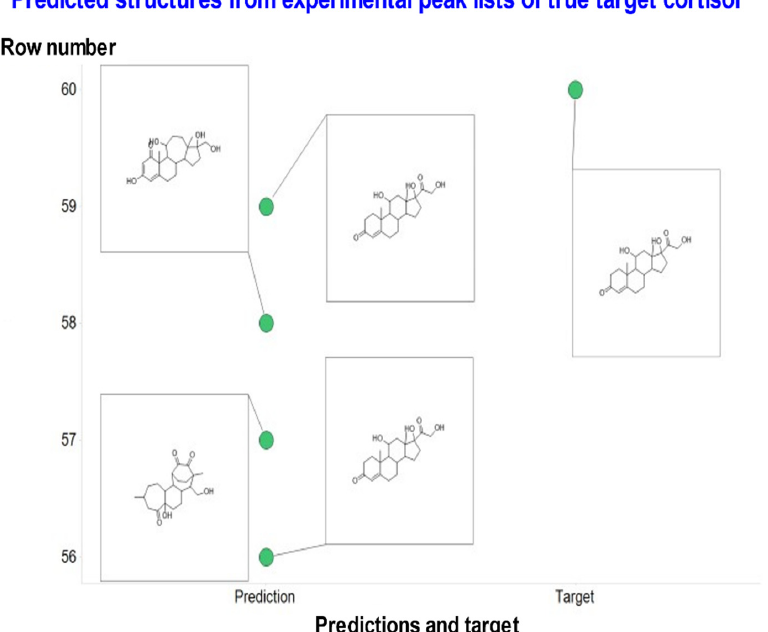
Figure 6. Illustration of the predictive power of MassGenie when presented with an experimental peak list (363.21631, 121.06477, 105.06985, 97.0648, 91.05423, 327.19522, 119.08553, 309.18469, 109.06478, 145.10121, 93.06989, 131.08549, 123.08039, 79.0542, 143.08563) of the true molecule cortisol, along with its canonicalized best proposals. In this case 2/4 are correct (and to a chemist’s eye far more biologically